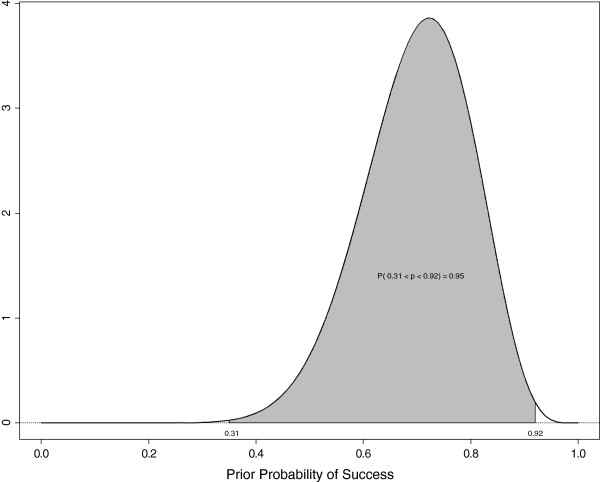
The probability density function for σeand 95% prior probability interval.